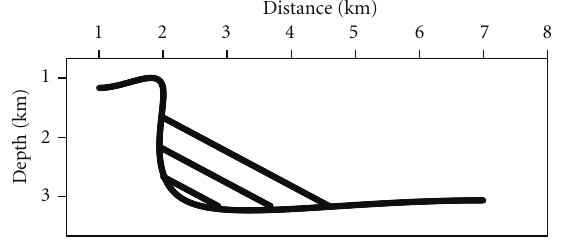
Figure 3: A reflector model depicting a salt flank with three parallel reflectors laying alongside the flank. The angle of symmetry is normal to the three reflectors at 30 degrees from the vertical.